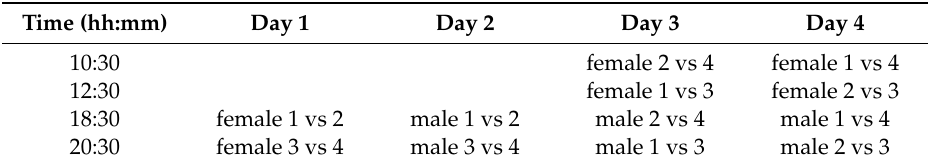
Table 1. Match schedule of the